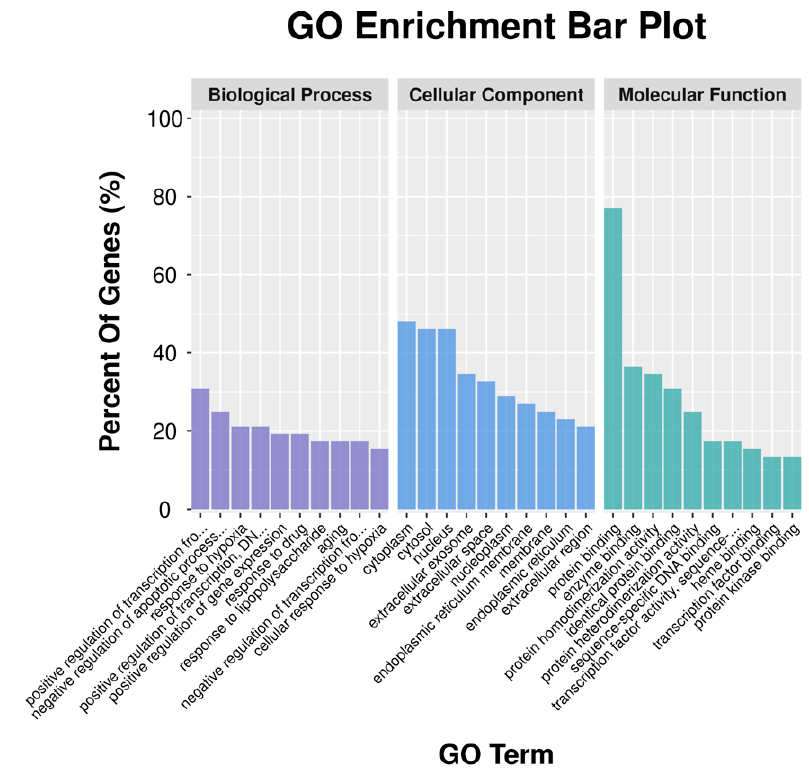
Figure 3. Gene Ontology (GO) enrichment analysis for potential targets of PBL.